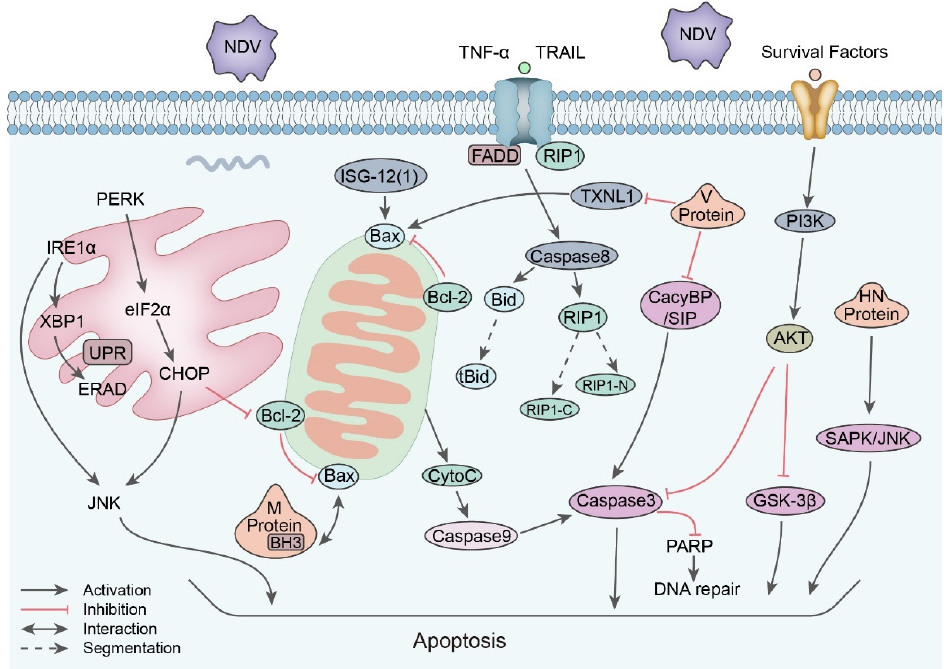
Figure 3. Apoptosis signaling pathway induced by